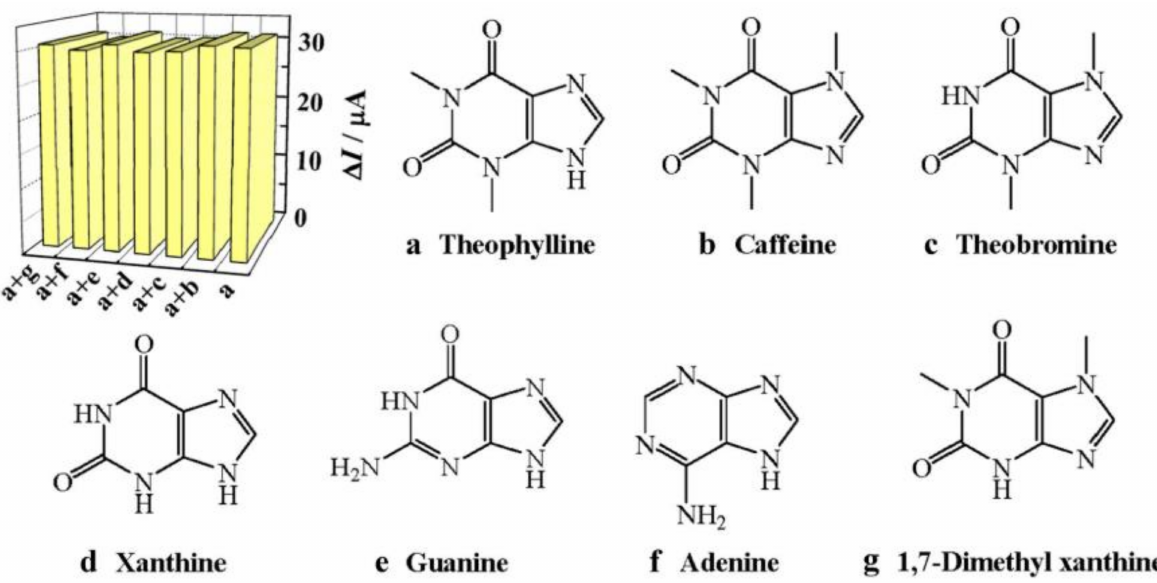
Figure 6. DPV responses on SiO 2 @TiO 2 @MIP/CPE for 1.0 µ M theophylline present in binary mixture (1:5) with structural analogs, reprinted with permission from [60], ©